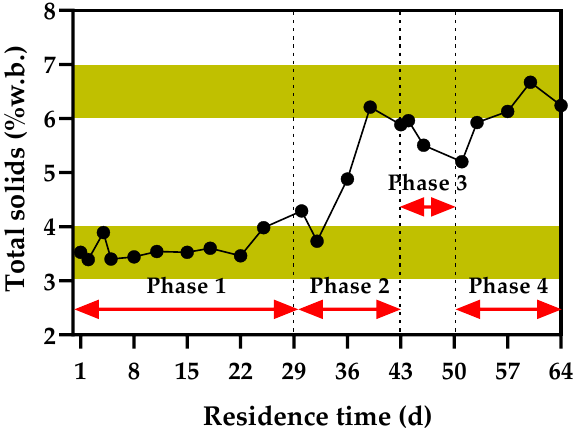
Figure 5. Total solids (TS) content of digestate during anaerobic digestion process.